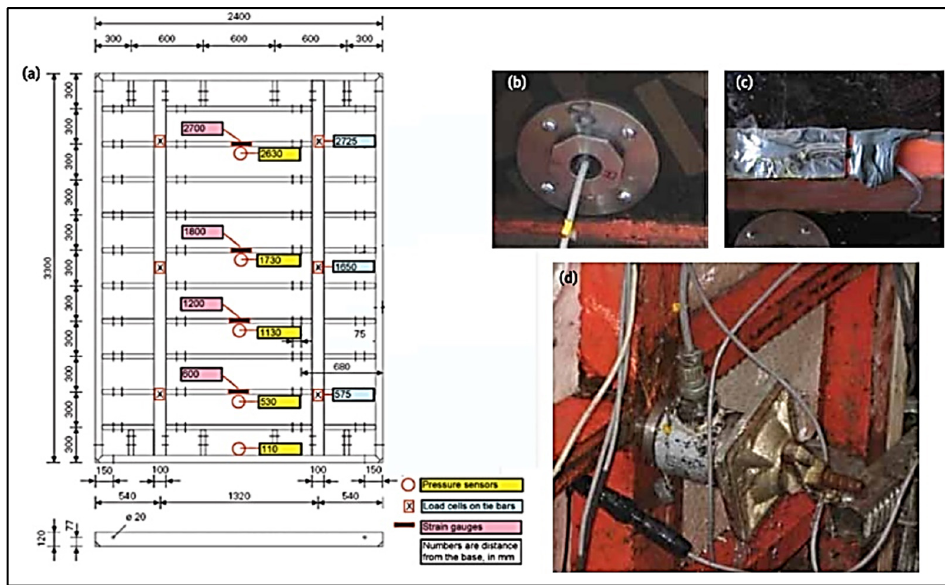
Figure 6. Full-scale experimental setup for pressure measurement: ( a ) location of sensors; ( b ) mounted pressure sensor; ( c ) strain gauge; ( d ) load cells [80] (reprinted with permission from © ACI).